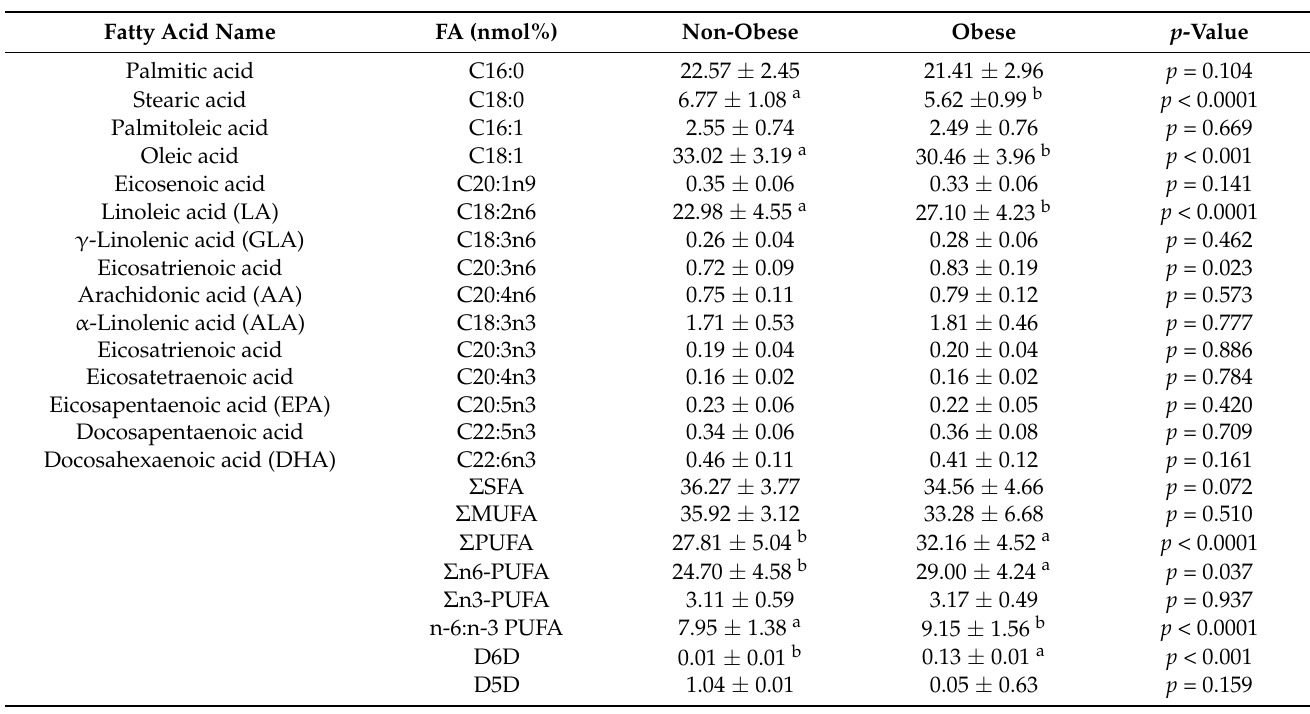
Table 2. The fatty acid composition of breast milk from non-obese women and women with obe- sity (obese).